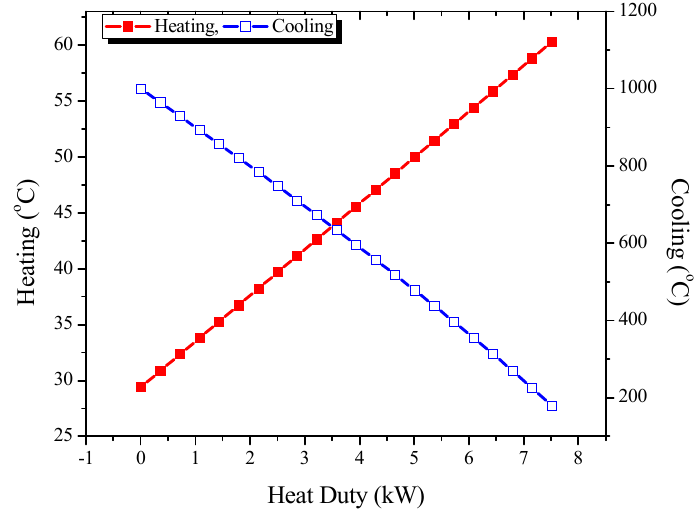
Figure 5. Heating and Cooling Curves of Boiler.